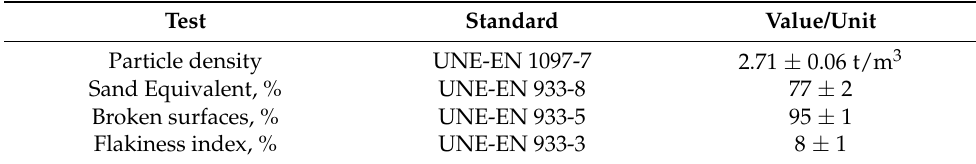
Table 6. Physical properties of the leaching residue.